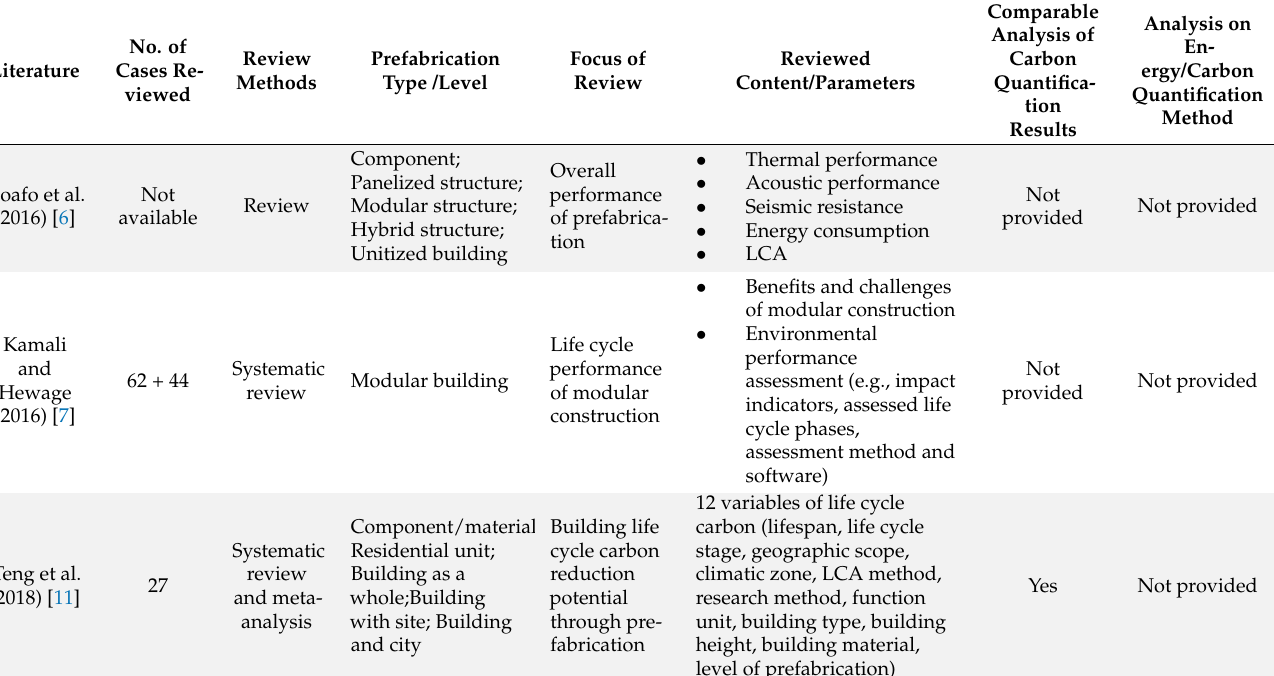
Table 1. Previous reviews on the carbon emission (energy consumption) of prefabricated